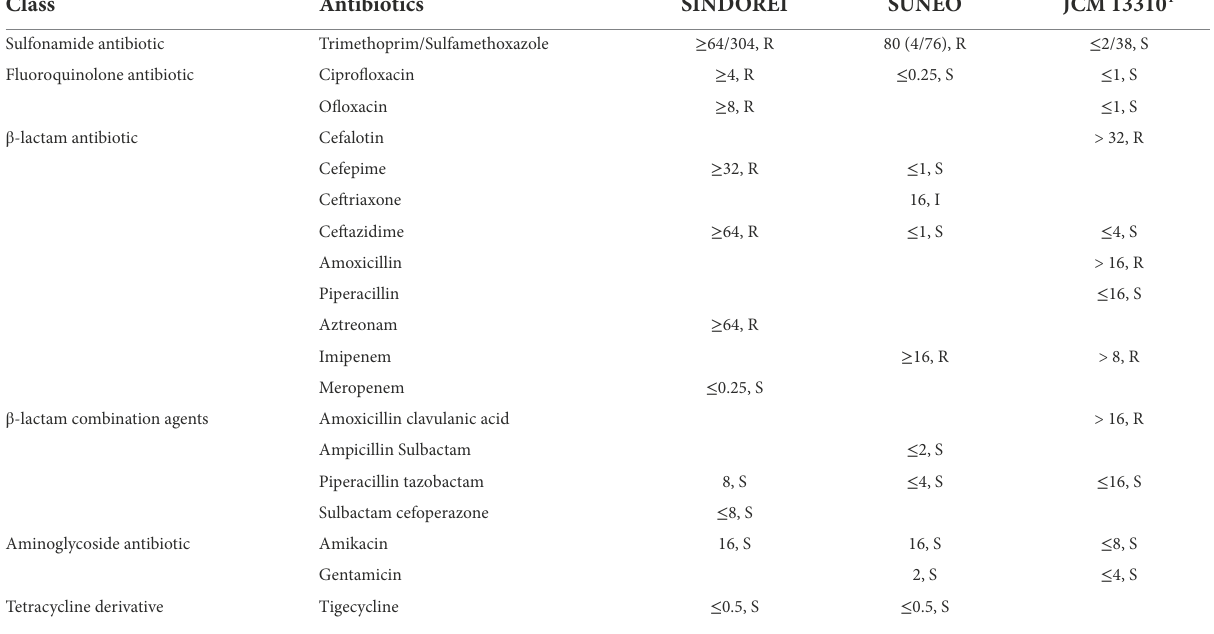
TABLE 3 Antimicrobial susceptibility test of Stenotrophomonas acidaminiphila SINDOREI, SUNEO and JCM 13310 T .